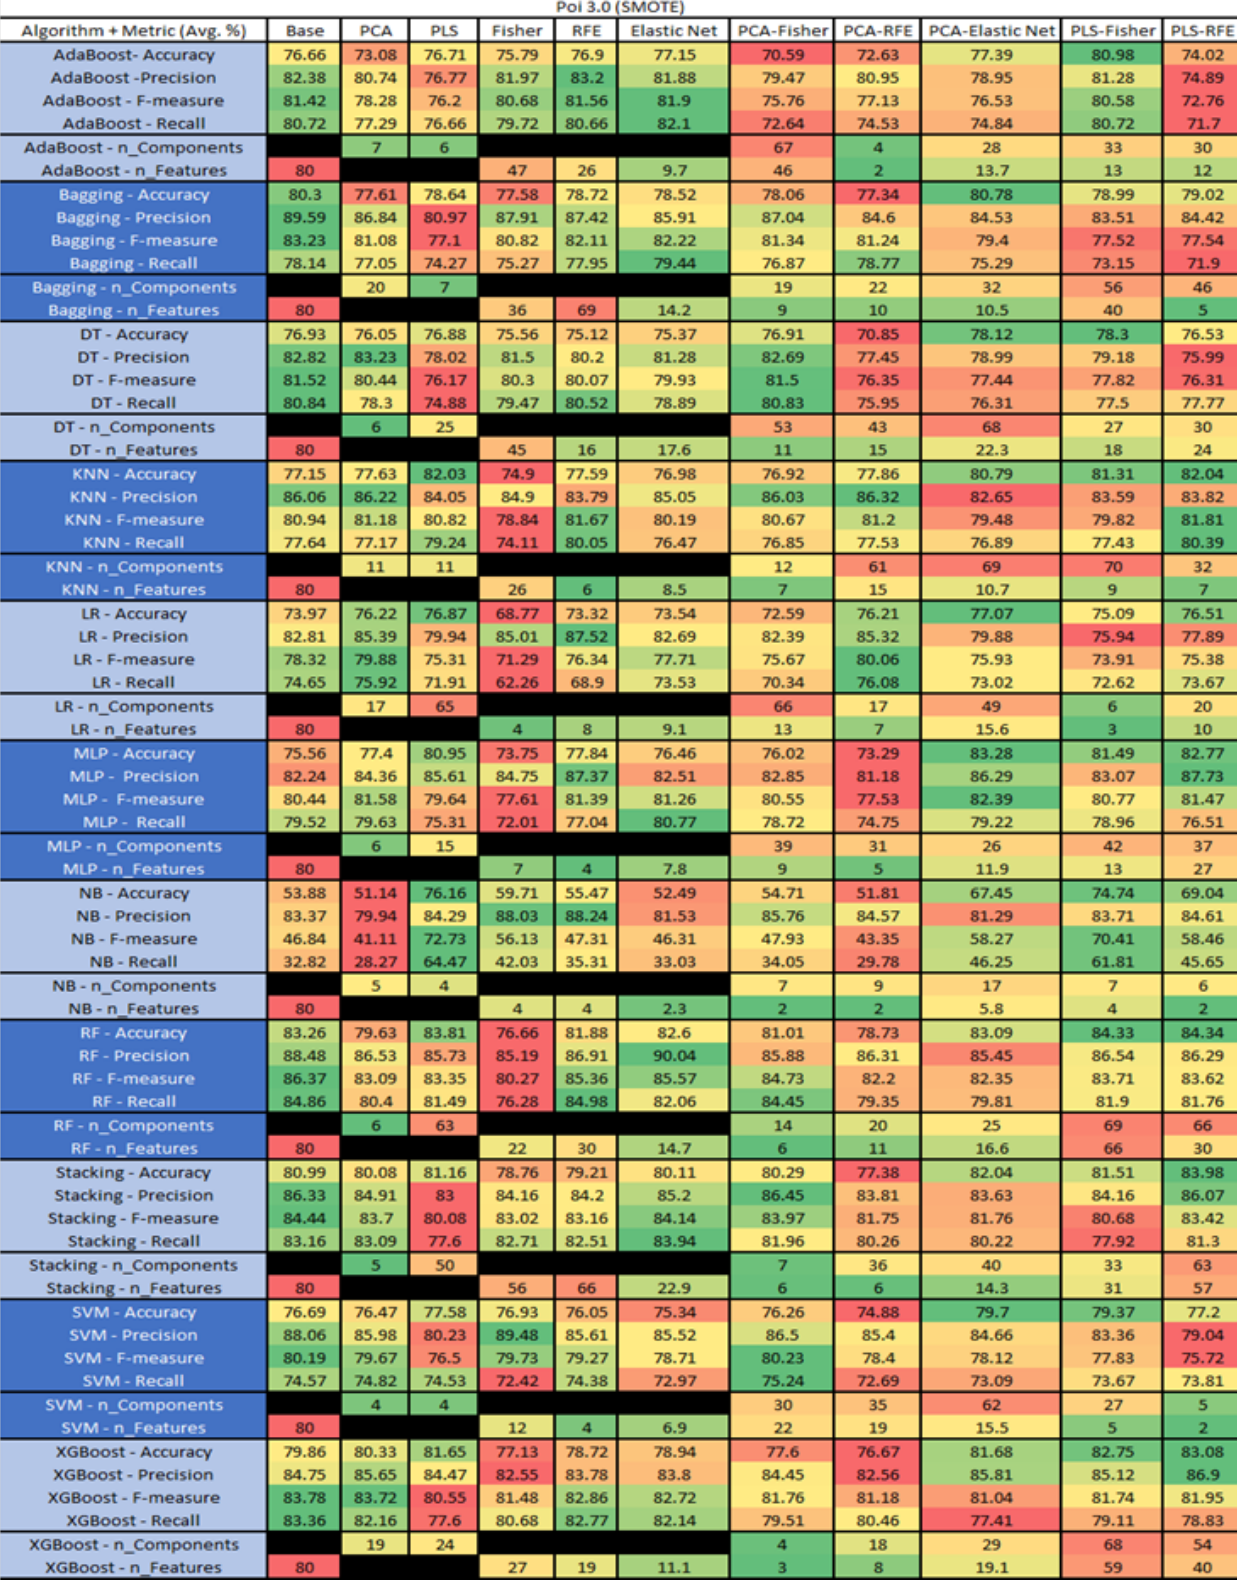
Figure 51. Poi 3.0 SMOTE PROMISE Results Data